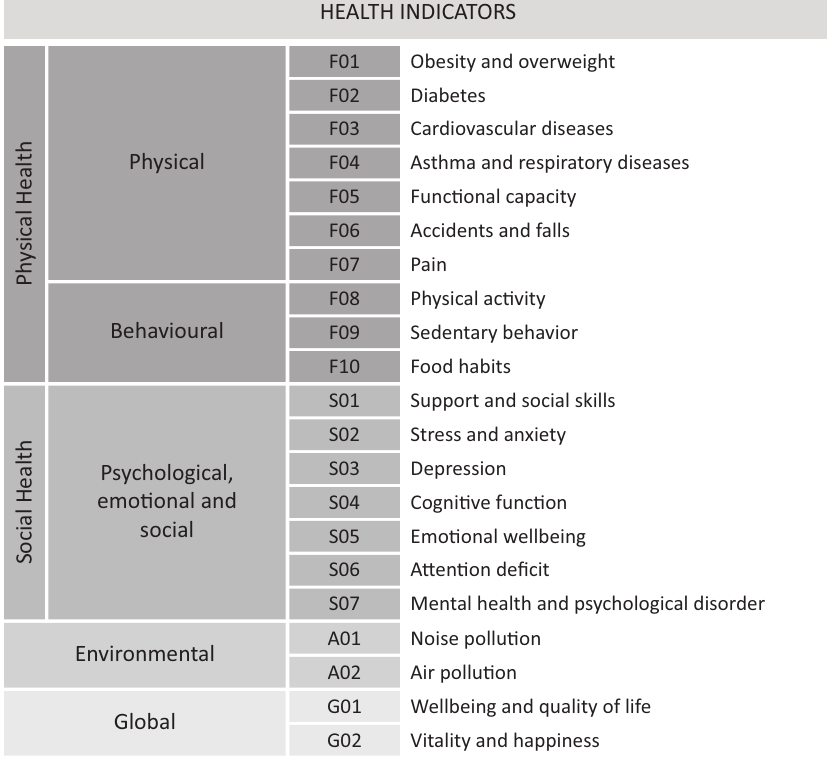
Figure 4. Health indicators (n = 21) significantly associated with urban planning